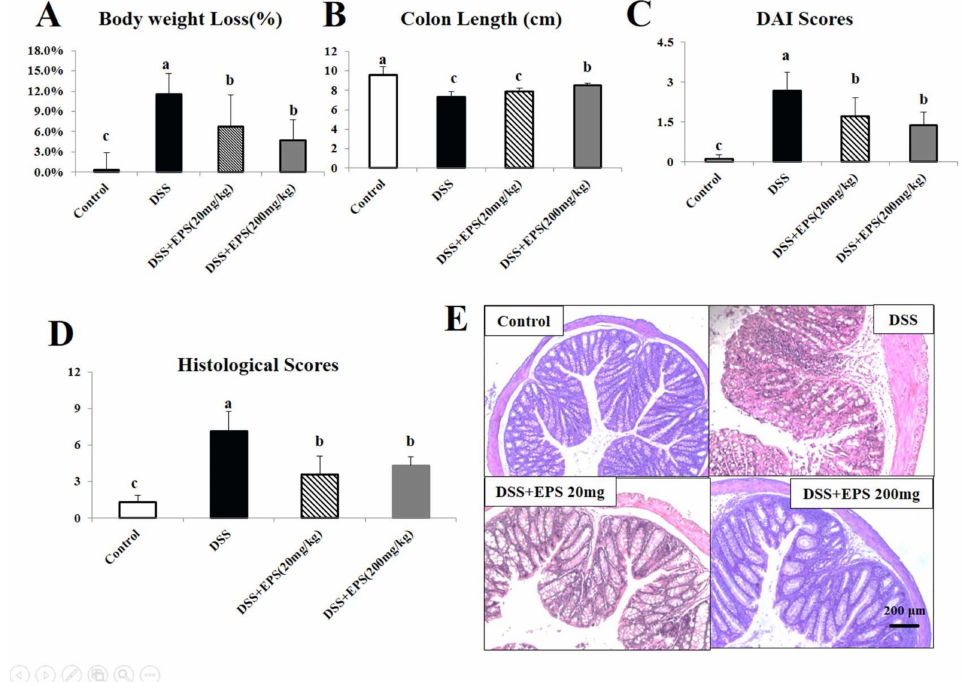
Figure 2. EPS-1 attenuates DSS-induced acute murine colitis. ( A ) Body weights loss, ( B ) variations of colon length, ( C ) disease activity index (DAI), and ( D ) histological scores of mice from each treatment group. ( E ) Representative HE staining colonic tissue from each treatment group, scale bars, 200 µ m. Values with different superscript letters (a, b, c, d) are significantly different ( p <